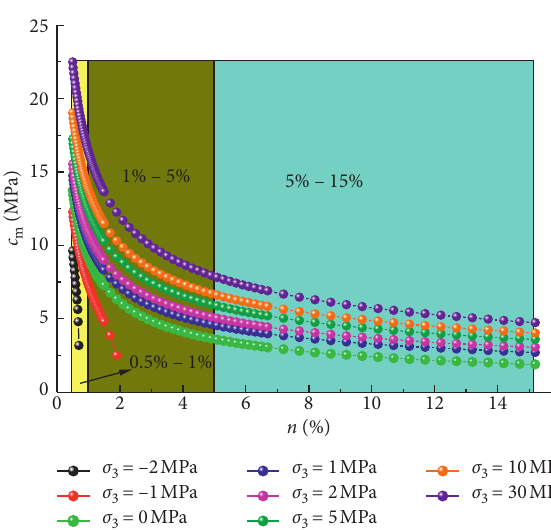
Figure 9: The change laws of φ